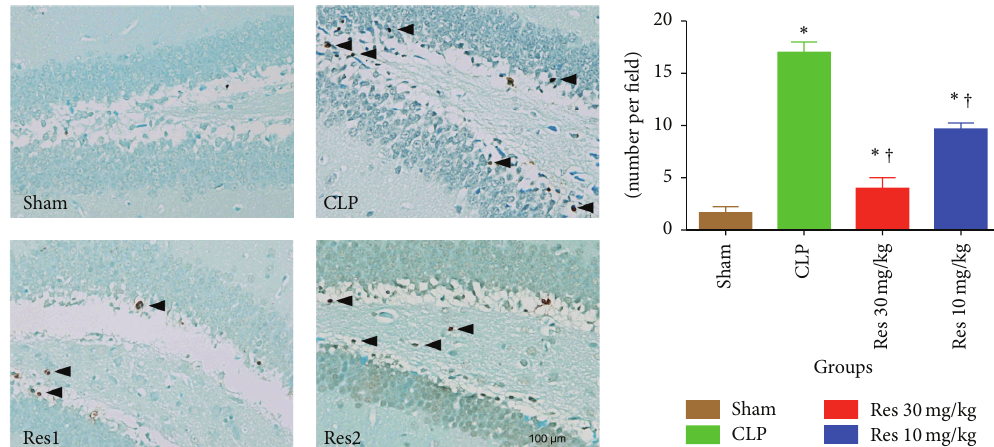
Figure2:ApoptosisinthehippocampusofsepticmicebytheTUNELassay.Resveratrolwasseentosignificantlydecreasetherateofapoptosis of cells in the hippocampus, in relation to the CLP treated group. ∗ 𝑃 < 0.05 compared with Sham group and † 𝑃 < 0.05 compared with CLP group by one-way ANOVA and LSD tests. Bars represent the mean ±